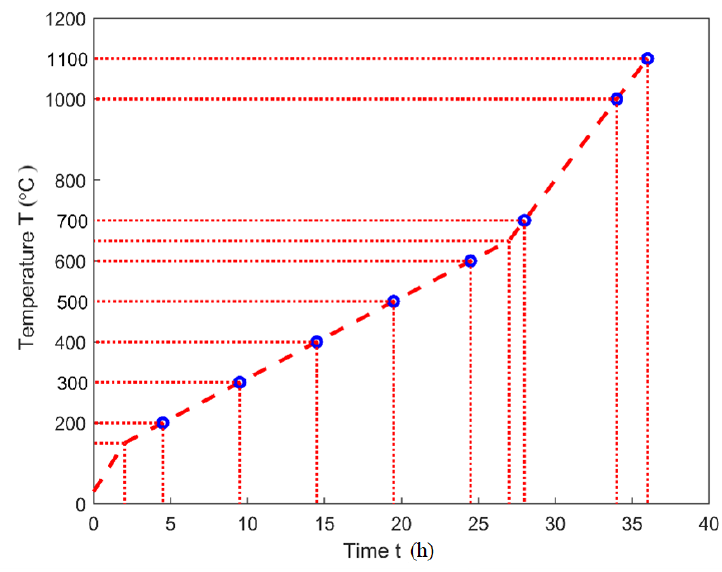
Figure 2. Heating program [28]. Table 3. Sample dimensions for different